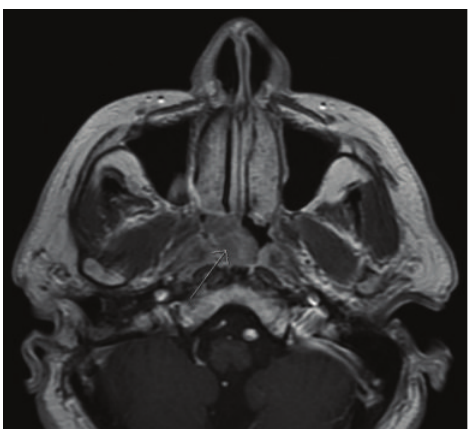
Figure 1: T1 weighted axial MRI demonstrating incidentally found polypoid, exophytic mass in the right nasopharynx.